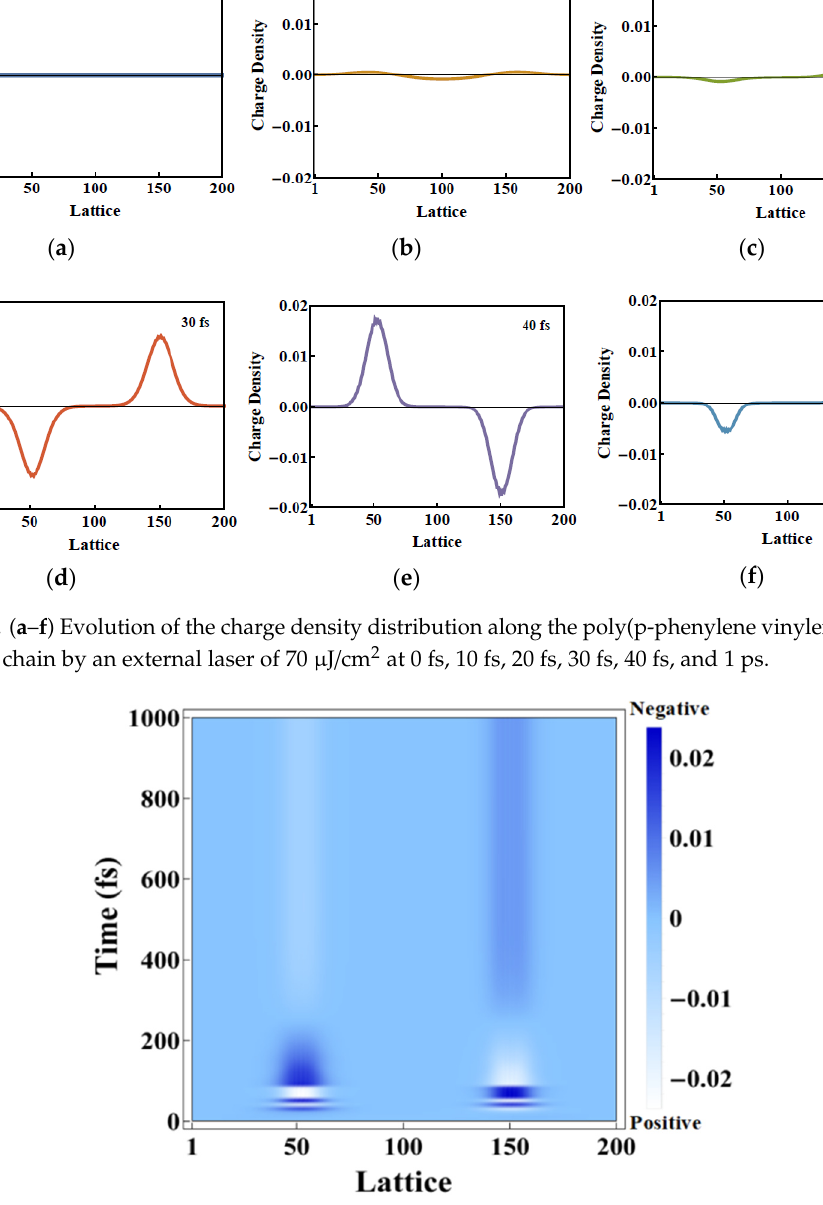
Figure 7. Evolution of the charge density distribution along the PPV polymer chain by an external laser of 70 µJ/cm 2 .